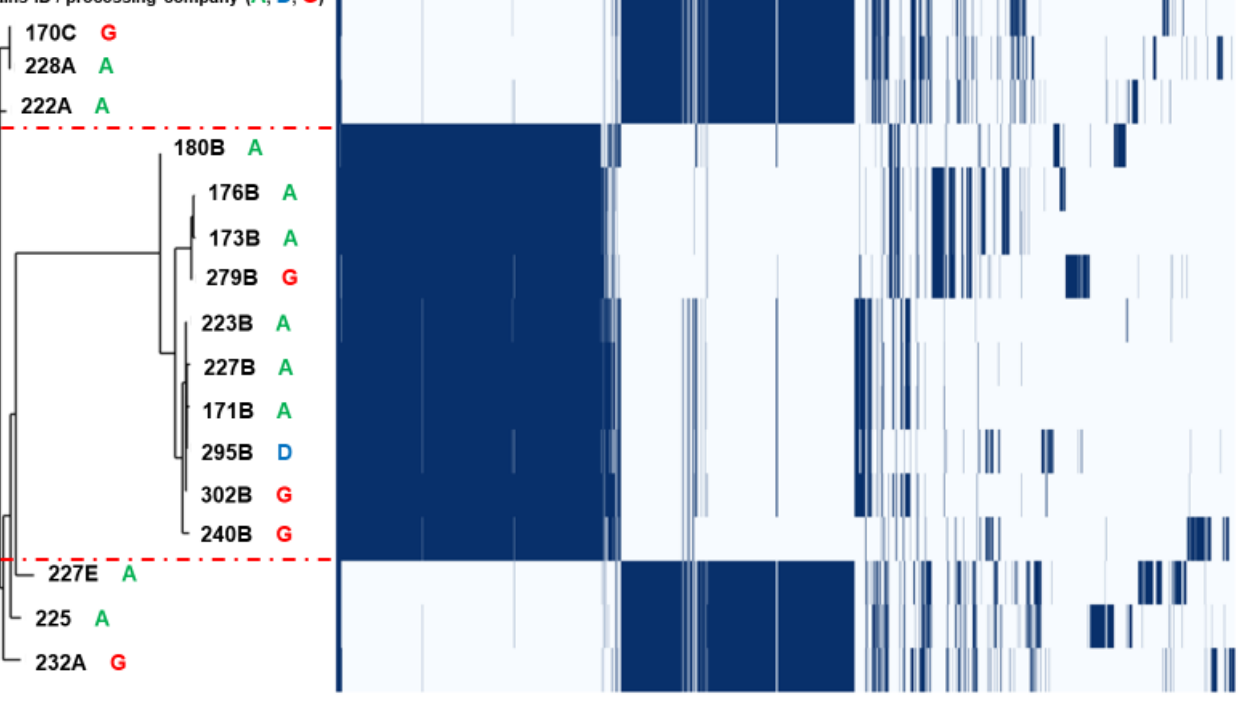
Figure 2. Pan-genome genetic relatedness analysis (utilizing the Roary (v3.20.0) pan-genome pipeline) of sixteen optrA -carrying linezolid-resistant Enterococcus spp. strains from retail chicken carcasses (from three processing companies: A, D, and G). Clustering was completed according to strains profiles by gene content. A total of 7,651 genes were identified. Left: core-genome phylogeny; the three E. faecalis clusters (10 isolates) in the dendrogram are delineated by red dotted lines. Right: heatmap of the core genes. Each row shows the gene profile of each isolate (gene presence (blue)/absence (white) matrix from the pan-genome analysis).